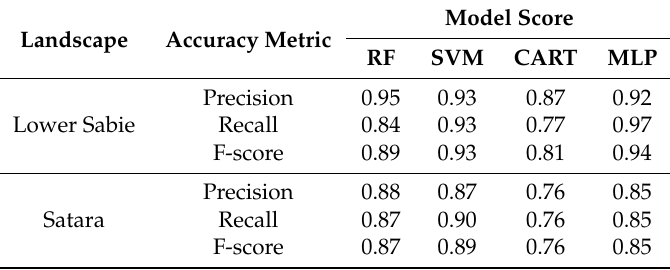
Table 6. Model Precision, Recall and F-score metrics of grazing lawn detection in both Lower Sabie and Satara landscapes. RF = Random Forest, SVM = Support Vector Machines, CART = Classification and Regression Trees, MLP = Multilayer Perceptron.